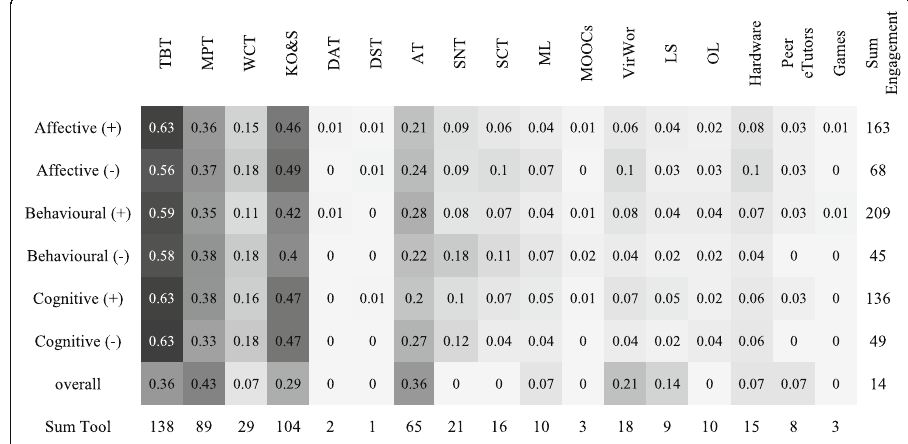
Fig. 5 Engagement and disengagement by tool typology. Note. TBT = text-based tools; MPT = multimodal production tools; WCT = website creation tools; KO&S = knowledge organisation and sharing tools; DAT = data analysis tools; DST = digital storytelling tools; AT = assessment tools; SNT = social networking tools; SCT = synchronous collaboration tools; ML = mobile learning; VW = virtual worlds; LS = learning software; OL = online learning; A&H = Arts & Humanities; BA&L= Business, Administration and Law; EDU = Education; EM&C = Engineering, Manufacturing & Construction; H&W = Health & Welfare; ICT = Information & Communication Technologies; ID = interdisciplinary; NS,M&S = Natural Science, Mathematics & Statistics; NS = Not specified; SoS = Social Sciences, Journalism &